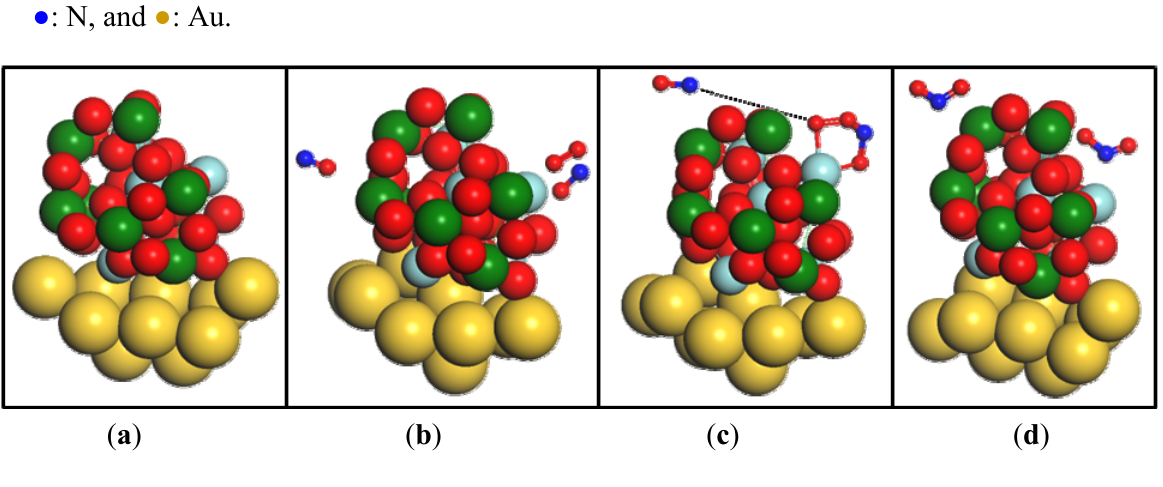
), ( c ) transition state structure, and 2 molecules). ● : Y, ● : Zr, ● : O, 2